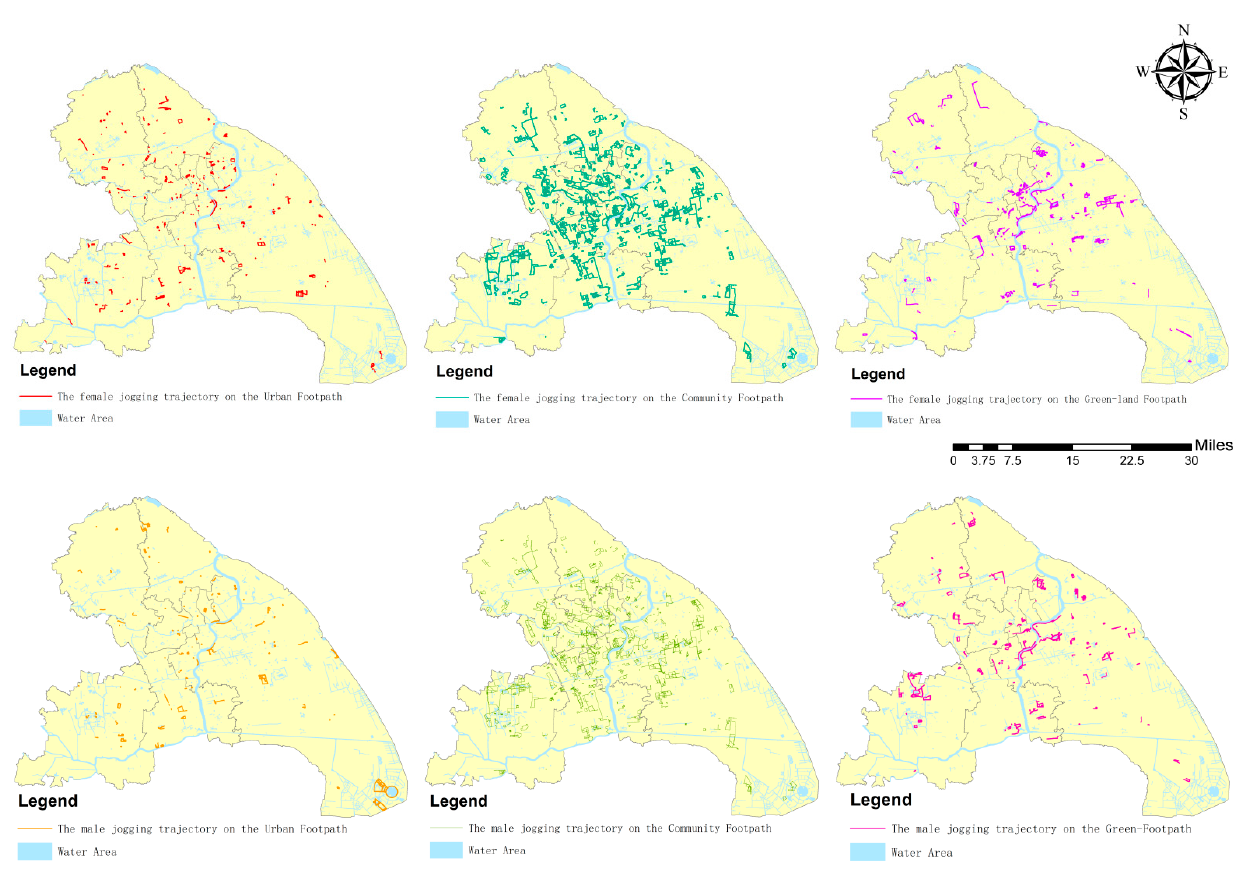
Figure 4. Distribution of JA on each footpath for different gender.